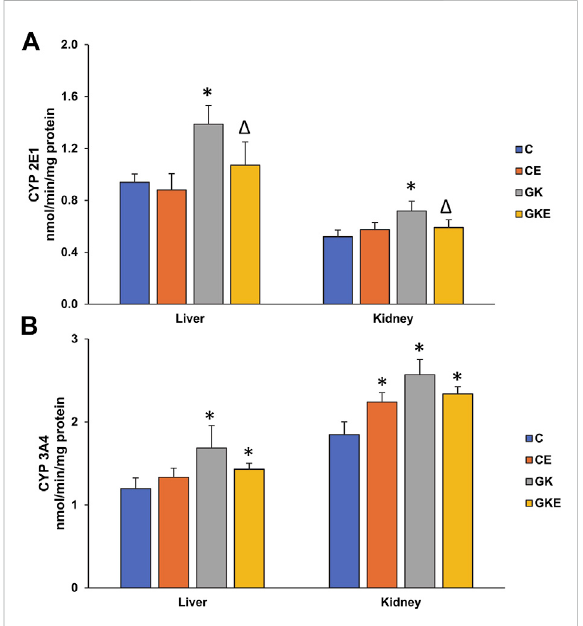
FIGURE 3 Exercise-induced alterations in CYP 450 enzyme activities in the liver and kidney of control Wistar (C) and diabetic GK (GK) and exercise-trainedcontrol(CE)andGK(GKE)rats( n =5).Microsomal CYP 2E1 (A) and CYP 3A4 (B) were measured using dimethyl nitrosamine and erythromycin as substrates as described in the Materials and Methods. Histogram values are mean ± of three independent experiments and statistical signi fi cance is shown as asterisks, which was fi xed as p < 0.05 (* indicates statistical signi fi cance compared with control Wistar rat tissues while Δ indicates statistical signi fi cance compared with diabetic GK rat tissues).